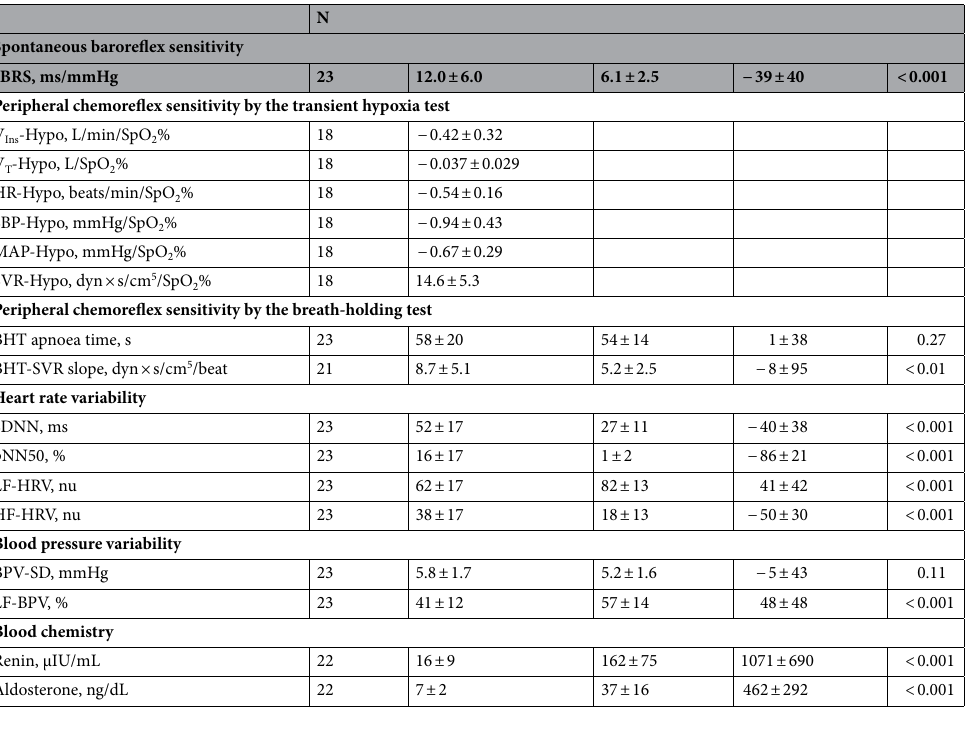
Table 4. Pre- and post-race values of autonomic parameters in the examined men. Data are presented as mean ± SD; cBRS, spontaneous cardiac baroreflex sensitivity as assessed with the sequence method; V Ins - Hypo, minute ventilation response to transient hypoxia; V T -Hypo, tidal volume response to transient hypoxia; HR-Hypo, heart rate response to transient hypoxia; SBP-Hypo, systolic blood pressure response to transient hypoxia; MAP-Hypo, mean arterial blood pressure response to transient hypoxia; SVR-Hypo, systemic vascular resistance response to transient hypoxia; BHT apnoea time, duration of the voluntary apnoea in the breath-holding test; BHT-SVR slope, SVR responsiveness in the breath-holding test; SDNN, standard deviation of RRIs; pNN50, the percentage of adjacent RRIs with a difference of duration > 50 ms; LF-HRV, the power of HRV spectrum within low-frequency range; HF-HRV, the power of HRV spectrum within high-frequency range; BPV-SD, standard deviation of beat-to-beat SBP; LF-BPV, the power of DBP variability spectrum within low-frequency